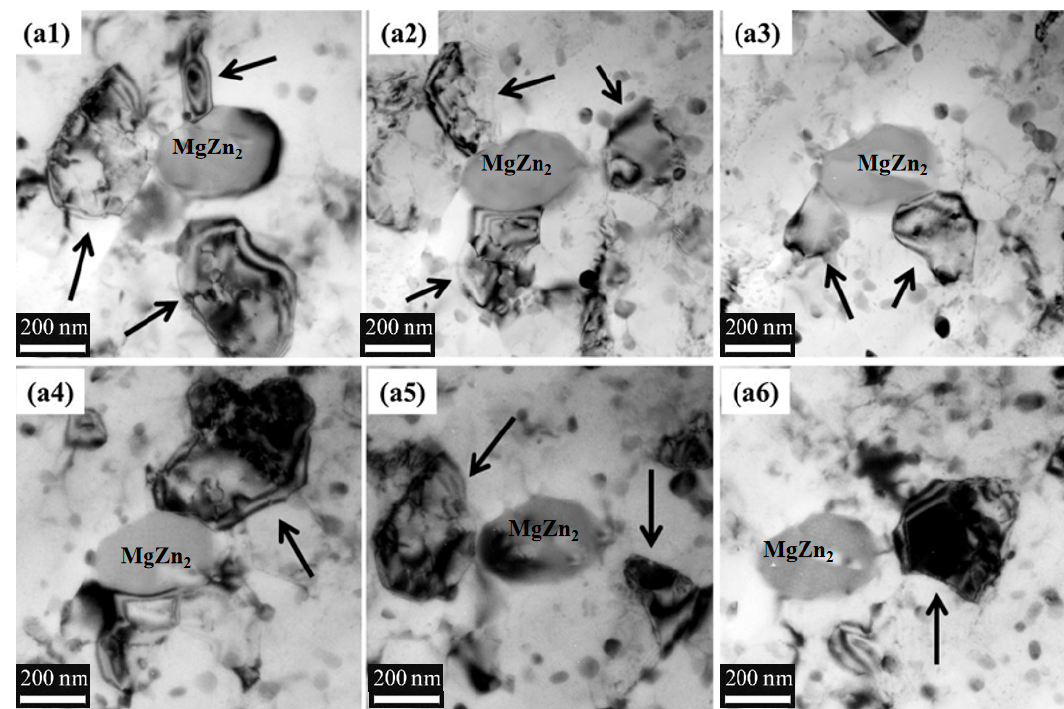
Figure 17. Preferential nucleation sites for recrystallization at large MgZn 2 grains (black arrows indicating well-developed subgrains; ( a1 – a6 ) show the same BF image with tilted specimen stages) [83].